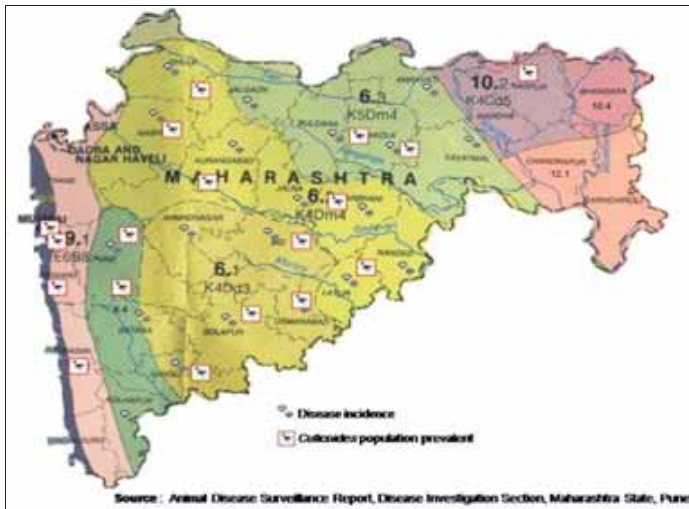
Figure-3: Map depicting prevalence of Culicoides spp. in Maharashtra